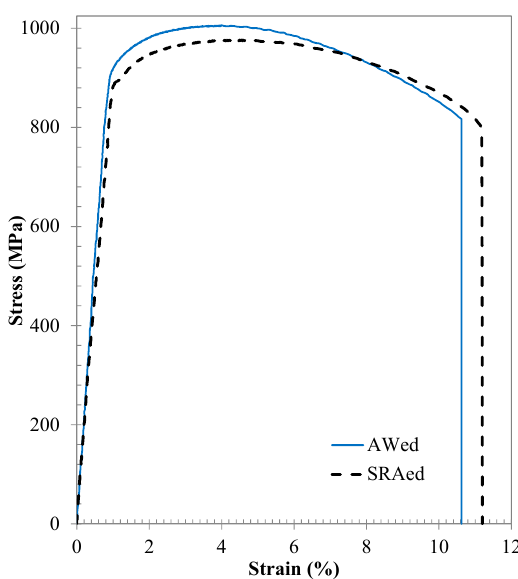
Figure 12. Average stress–strain behavior for dissimilar titanium alloy welds in the AWed and SRAed conditions. Table 5. Average mechanical properties of dissimilar joints between Ti-64 and Ti-6242. Table 6. Comparison of the tensile properties of similar and dissimilar titanium alloy linear friction welds.